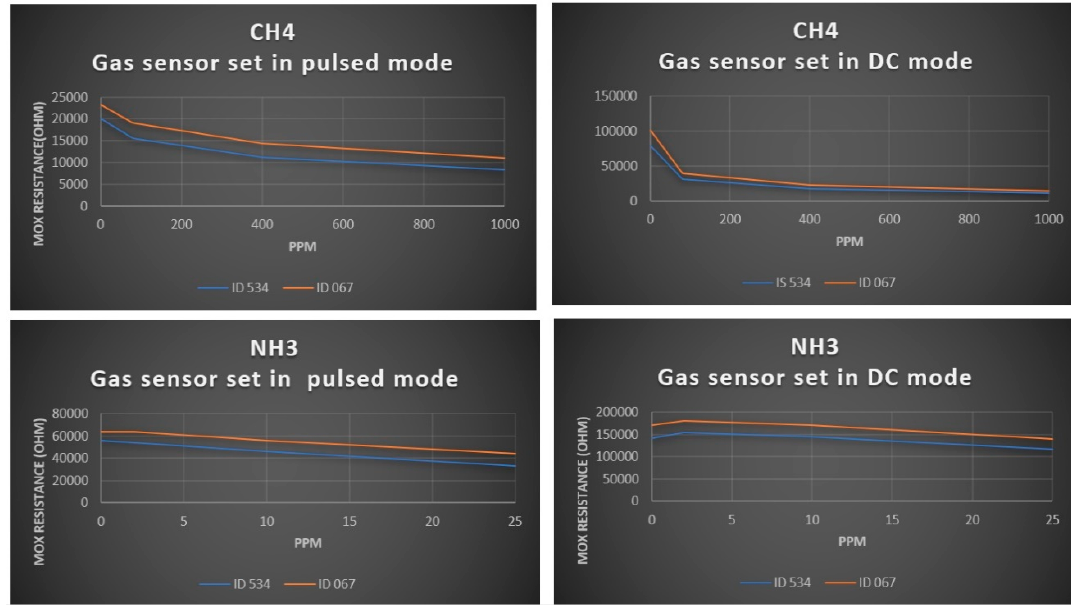
Figure 24. Gas sensor in the air probe showing direct relation between MOX (metal oxide) resistance and gas concentration.